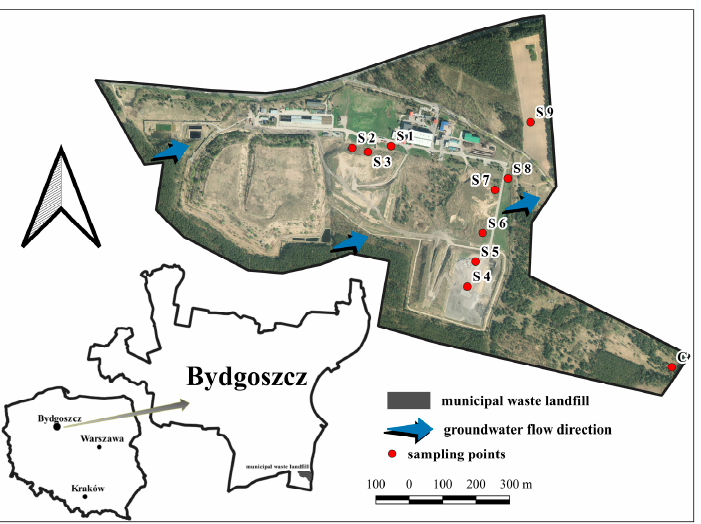
Figure 1. Location of study area. Legend : C—control site outside the landfill’s zone of impact; S1— site by the pumping station; S2—non ‐ active sector closed off for 2 years; S3—vicinity of the out ‐ flow of leachates from the non ‐ active sector; S4—landfill premises adjacent to a sector that has been in operation for 2 years (landfill basin); S5—site 5 m north from the basin of the active sector; S6—site 10 m north from the active sector; S7—site 50 m north from the active sector; S8—area adjacent to the landfill fence; S9—arable field of maize monoculture about 200 m north of the land ‐ fill premises.